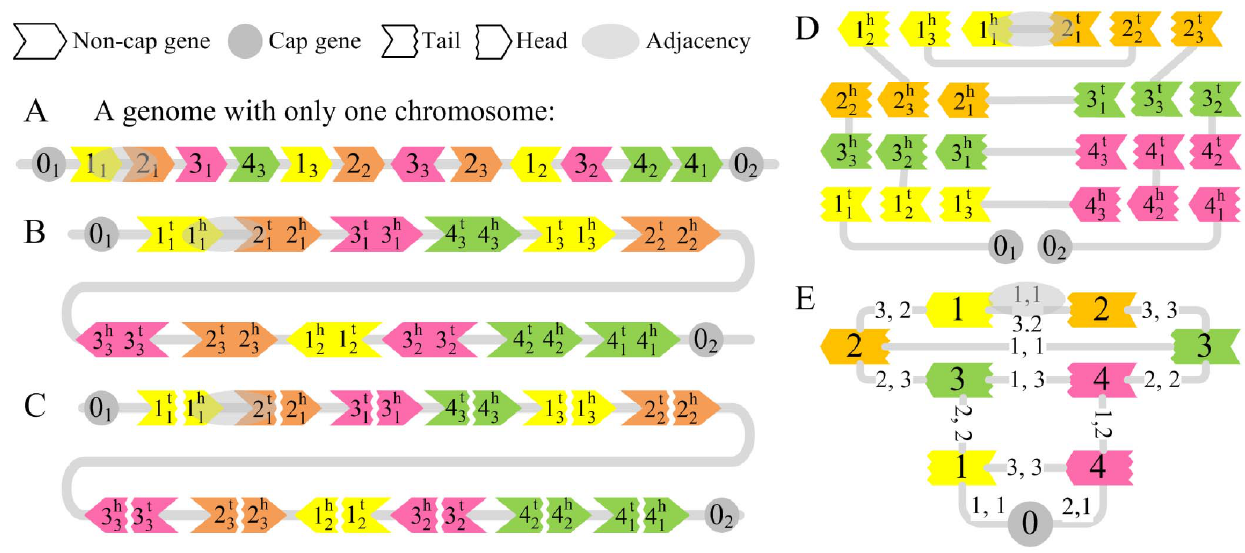
Figure 1. Representation of a genome, a PG and a CPG. (A) A rearranged duplicated genome with duplicated size of 3 is represented as a sequence of signed integers, where a positive (negative) sign is represented by the direction of the colored arrow. (B) The same genome is represented as a sequence of extremities (i.e., heads, tails or cap genes). (C) PG of the above genome. Each non-cap gene is cut into head and tail, which becomes two vertices in the partial graph. (D) The vertex reposition of the PG in (C). (E) The contracted PG that is converted from the PG showed in (C) and (D). Each vertex corresponds to an extremity family. Numbers on each edge indicate the copy IDs (i.e., subscripts) of the two extremities connected by the corresponding adjacency. Note that the edge (1 h , 2 t ) in (E) corresponds to 2 adjacencies (or edges) in (C), so its multiplicity is 2.